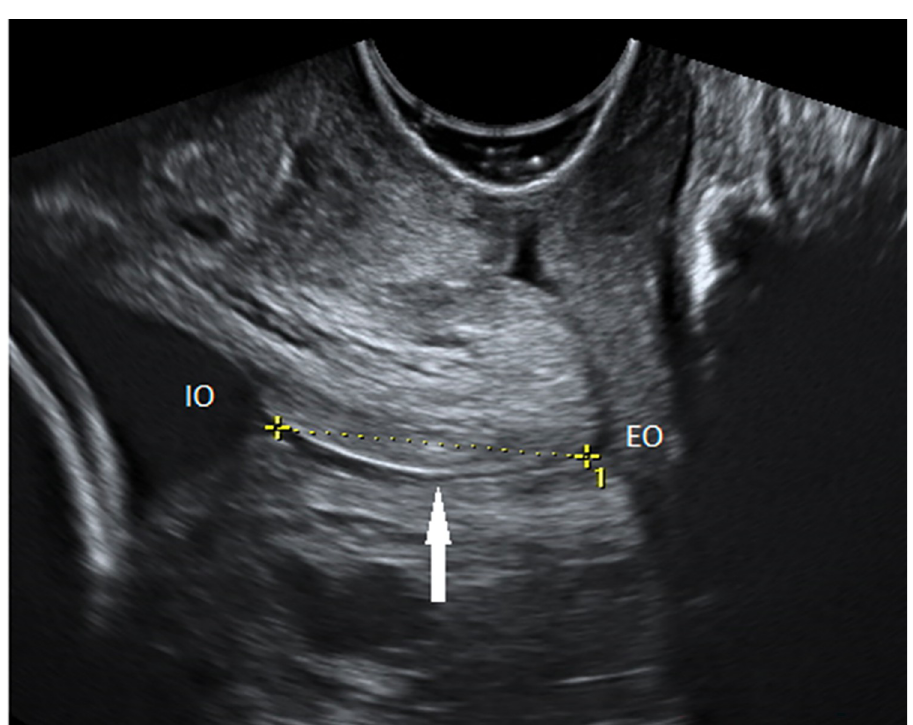
Fig 1. CL measurement in straight line technique. Transvaginal ultrasonography in sagittal section. The endocervical mucosa (arrow) is used as a guide to identify the internal (IO) and external (EO) os. The straight-line technique is presented (dashed